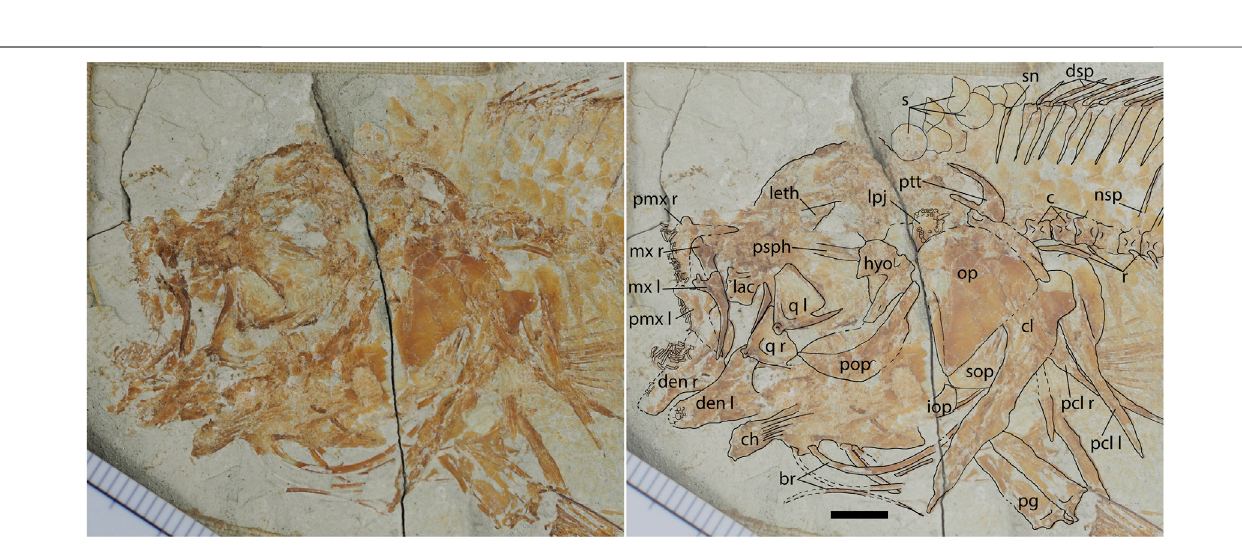
FIGURE2| Photographandinterpretationoftheheadoftheholotypeof Somalichromishadrocephalus gen.etsp.nov.,NHMUKP.29574.Scalebarequals5 mm.